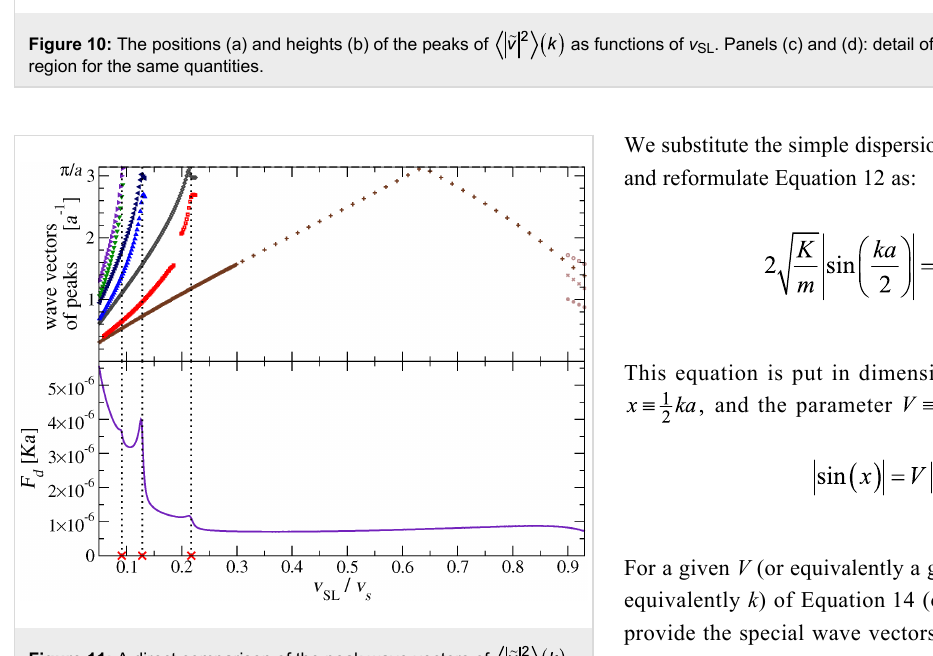
their phase velocities ω /| k | match the slider speed v SL . We start by searching all values of k such that the phonon phase velocity matches a given speed v SL